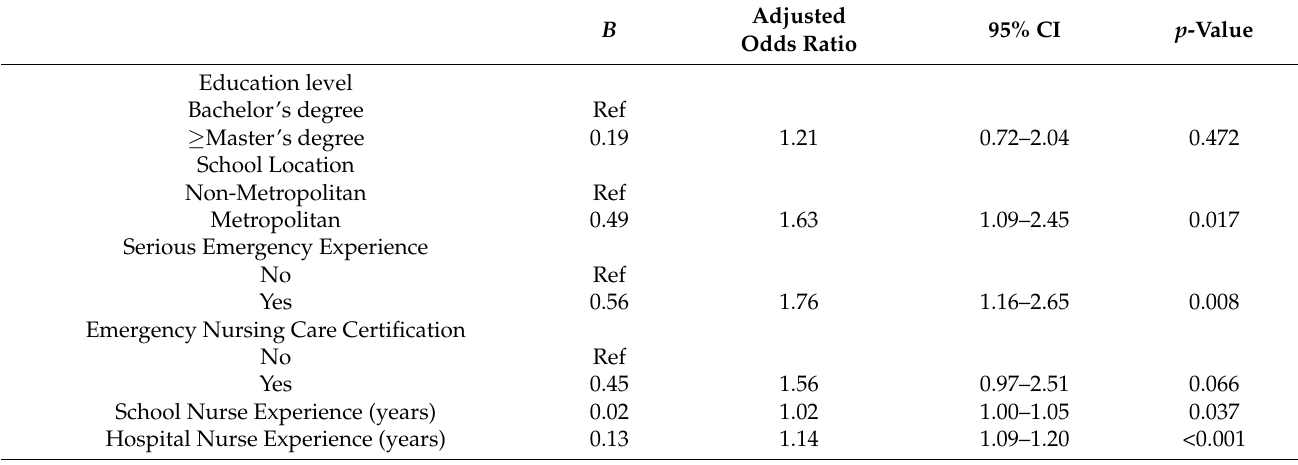
Table 3. Ordinal logistic regression analysis results for predicting factors related to triage competency ( n = 386).